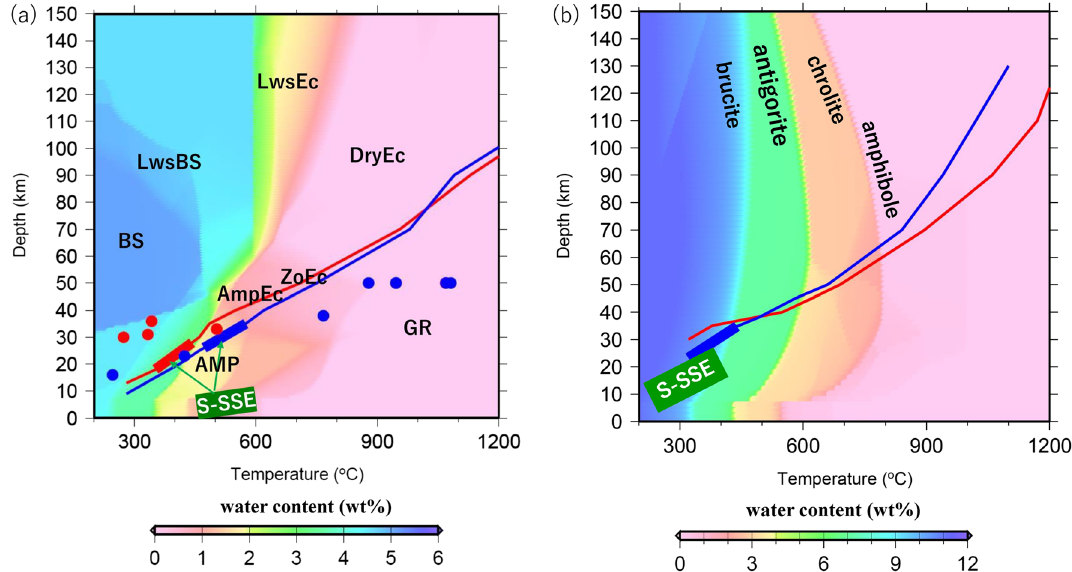
Figure 4. ( a ) Calculated temperature-depth paths in the phase diagram of the hydrous MORB 27 . The red- and blue-solid lines denote the temperature-depth paths at the surface of the oceanic crust of the PHS plate along profiles A and B (Fig. 1), respectively. The thick red and blue lines on the temperature-depth paths denote the temperature-depth ranges of the occurrence of S-SSEs along profiles A and B, respectively. BS, LwsBS, AMP, AmpEC, ZoEC, LwsEc, DryEc, and GR represent the phases of blueschist, lawsonite blueschist, amphibolite, amphibole eclogite, zoisite eclogite, lawsonite eclogite, dry eclogite, and granulite, respectively. ( b ) Calculated temperature-depth paths on the phase diagram of hydrous ultramafic rock 27 . The red- and blue-solid